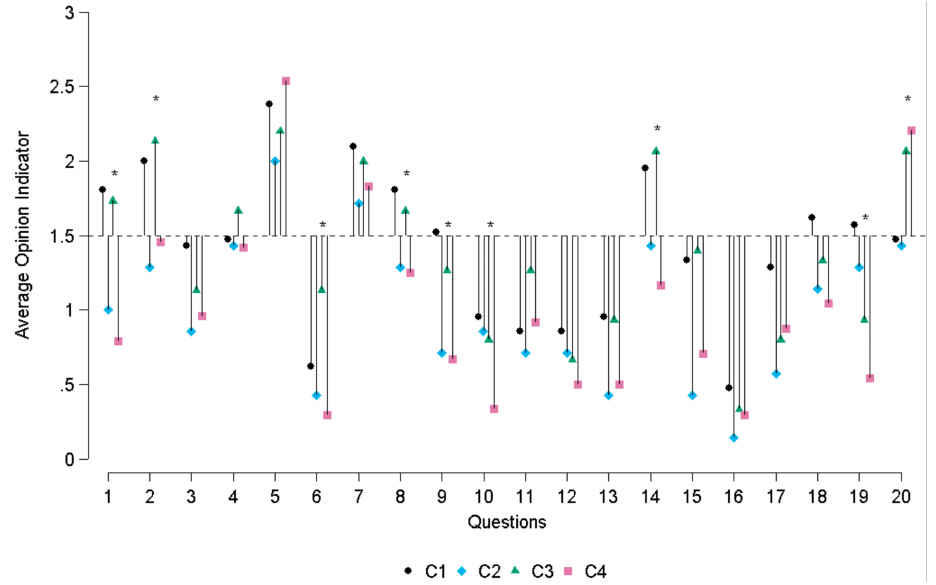
Figure 5. Aggregate opinion indicator of clusters for each